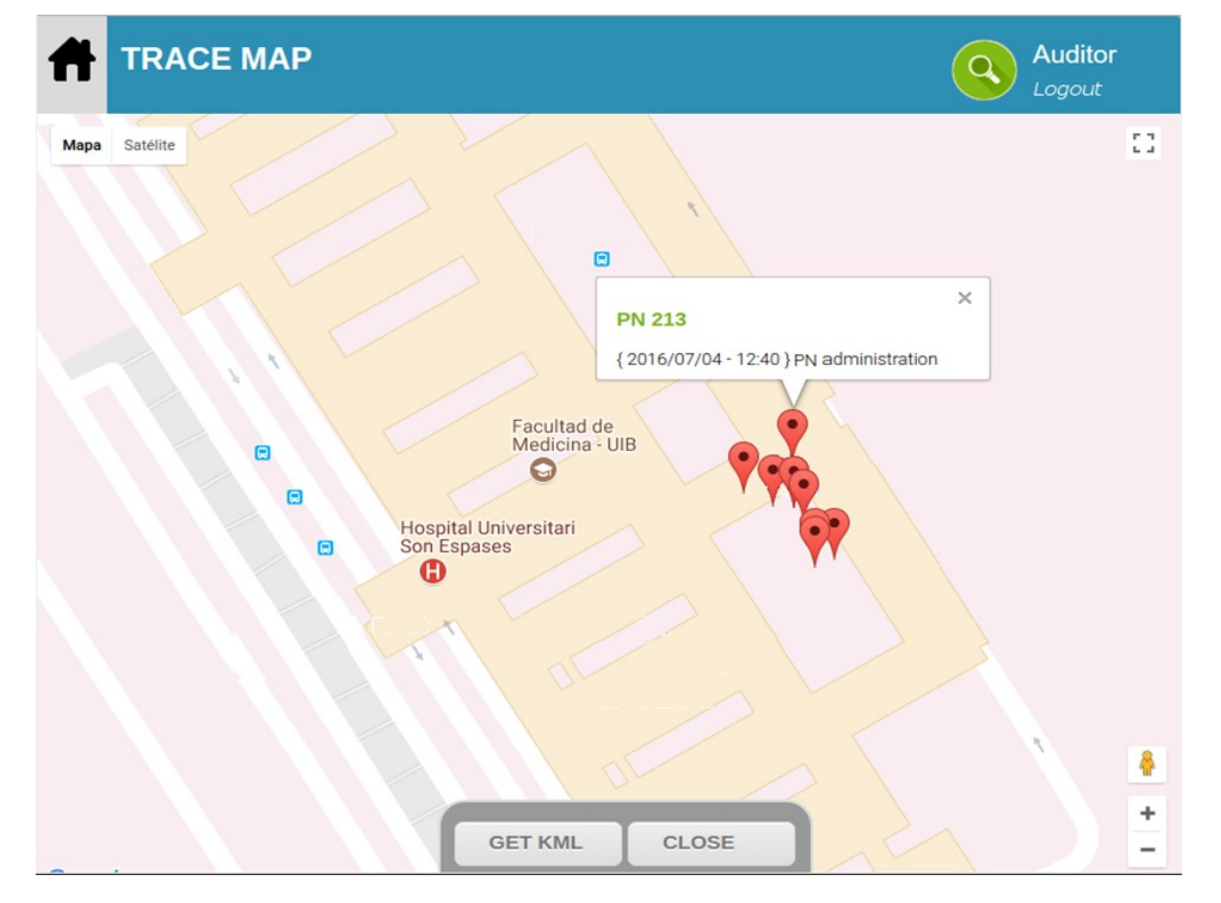
Figure 4. Collected data about the parenteral nutrition administration, including location, date, and time of administration. PN: parenteral